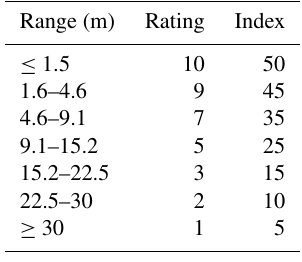
Table 1. Range and rating for depth of